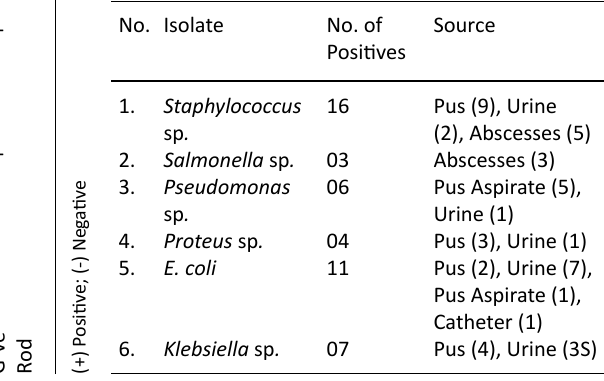
Table 4. Identification of